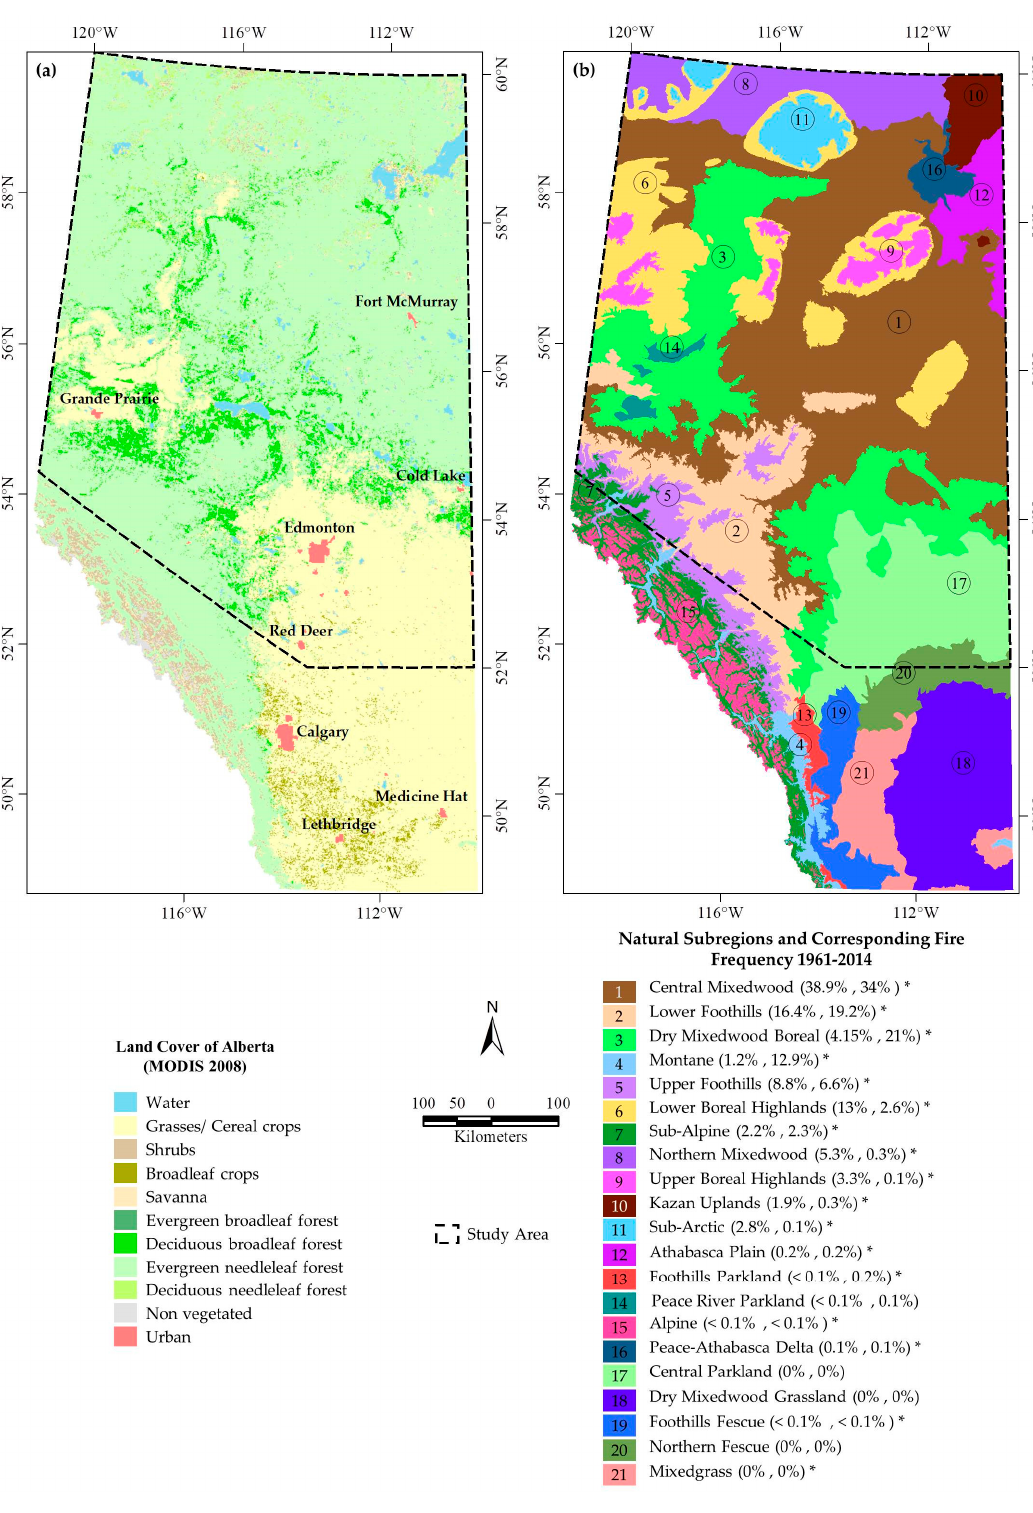
Figure 1. ( a ) Map showing the land cover of Alberta. The northern part was our study area. This area is dominated by the four different types of forest vegetation (i.e., evergreen and deciduous broadleaves, and evergreen and deciduous needleleaves) that were used in our four-day scale remote sensing (RS)-based forest fire danger rating system (FFDFS) modeling exercise. ( b ) Fire dynamics in different sub-ecoregions, where the asterisk marks, denote the subregions located in the study area.